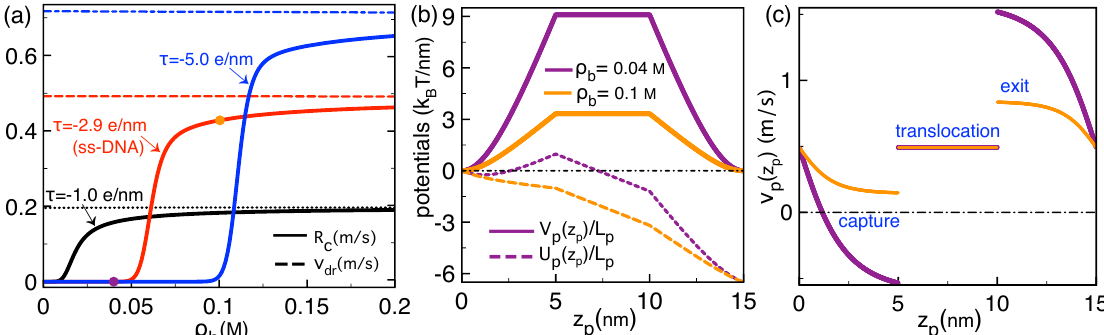
Figure 6. ( a ) Polymer capture rate R c in Equation (9) (solid curves) and drift velocity v dr of Equation (18) (dashed curves) in α HL pores against the bulk salt concentration ρ b at various linear polymer charge density values τ = − 2 π a σ p . ( b ) Polymer-pore interaction potential V p ( z p ) including image-charge forces (solid curves), effective potential U p ( z p ) from Equation (20) (dashed curves), and ( c ) velocity profile v p ( z p ) of Equation (16) at the salt densities ρ b = 0.04 M (purple) and 0.1 M (orange). In all plots, the pore and polymer lengths and radii are L m = 5 nm, L p = 10 nm, d = 8.5 Å, and a = 5 Å. The membrane is overall neutral ( σ m = 0) and the applied voltage is ∆ V = 120